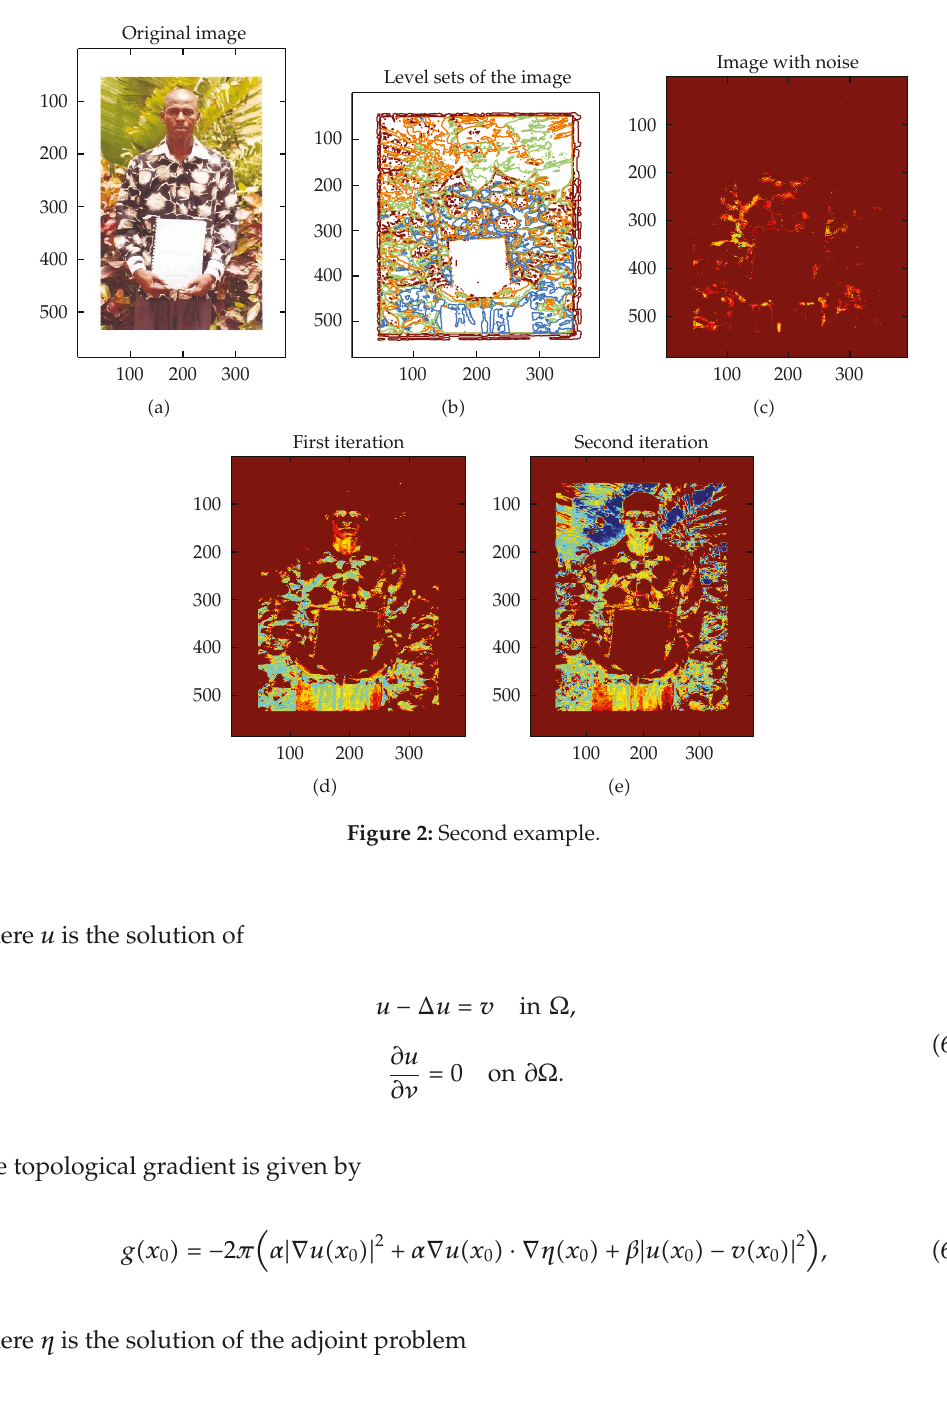
Figure 2: Second